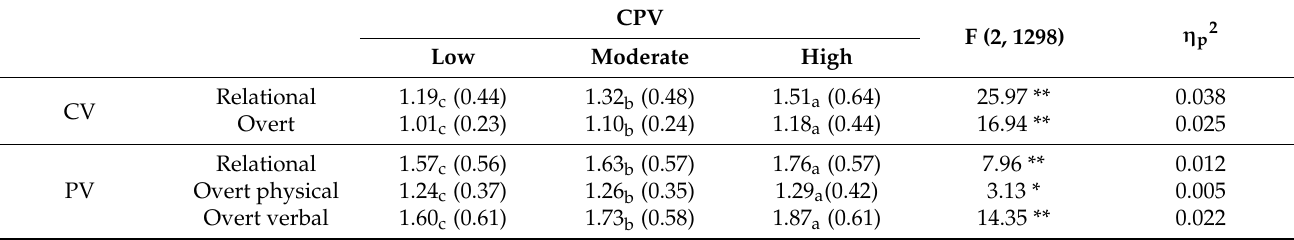
Table 2. Means, standard deviations and ANOVA results between child-to-parent violence (CPV), cybervictimization (CV) and peer victimization